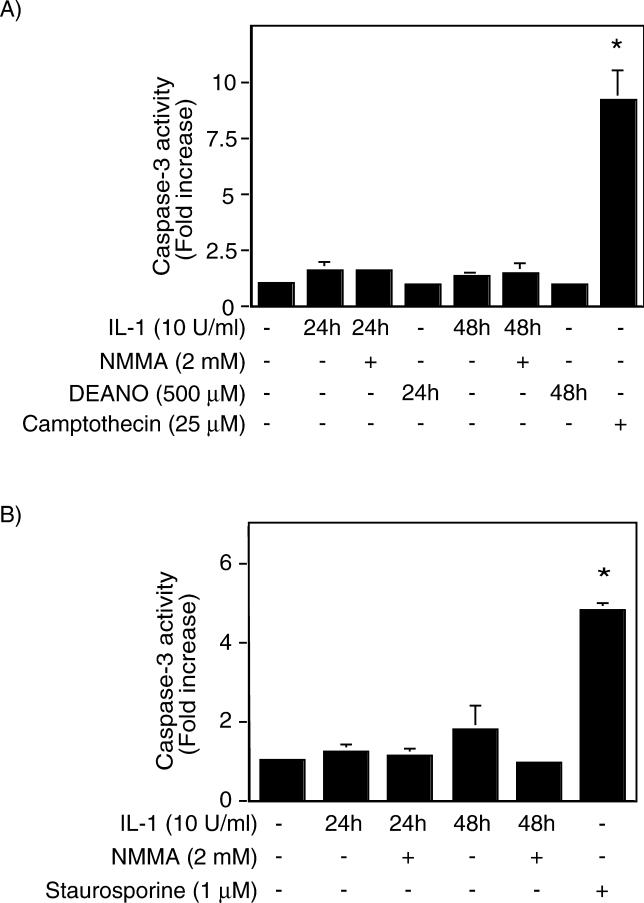
IL-1 Fails to Activate Caspase-3 in RINm5F Cells or Rat Islets(A) IL-1 (10 units/ml), alone or in combination with NMMA (2 mM) and the nitric oxide donor DEANO (500 μM), failed to activate caspase-3 in RINm5F cells following a 24- or 48-h exposure. As a positive control, the apoptosis inducer camptothecin (25 μM) stimulated a 9-fold increase in RINm5F cell caspase-3 activity.(B) Similar to RINm5F cells, in rat islets IL-1 (10 units/ml) alone or in combination with NMMA (2 mM) failed to activate caspase-3 following a 24- or 48-h incubation. The apoptosis inducer staurosporine (1 μM) stimulated a 5-fold increase in rat islet caspase-3 activity. Results are the average ± SEM of three independent experiments. *p < 0.05, significantly different from untreated control.